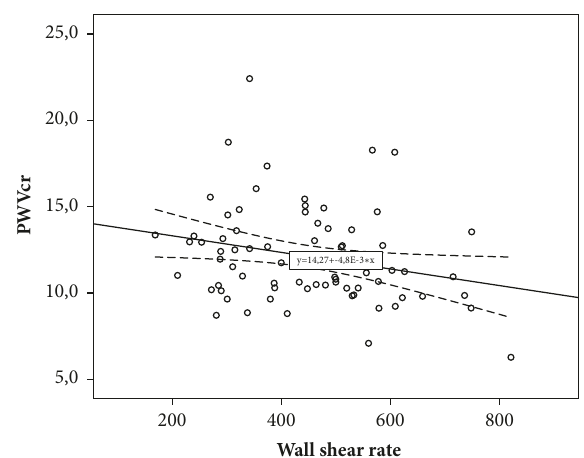
Figure 5: The relationship between wall shear rate and carotid- radial pulse wave